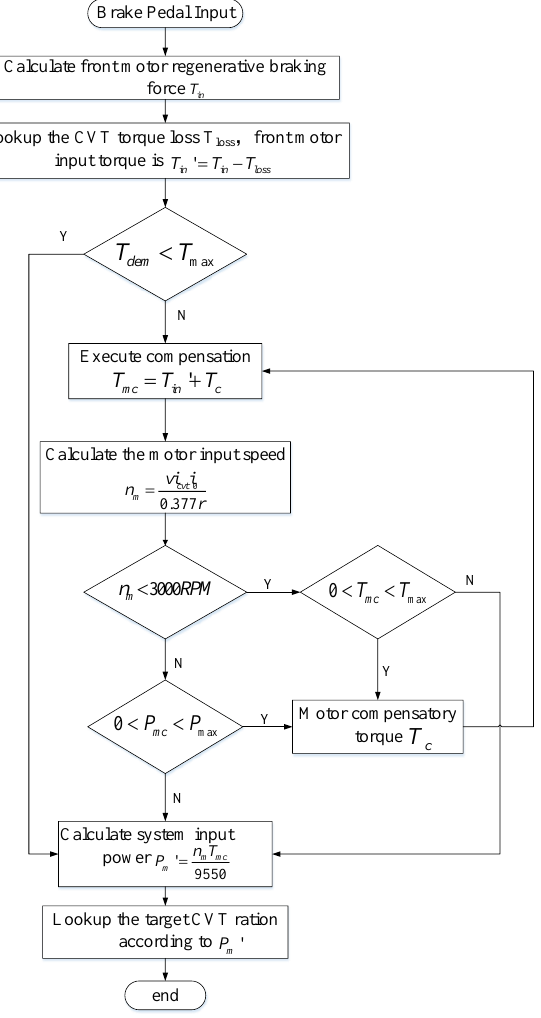
Figure 9. Target CVT ratio calculation flow chart.